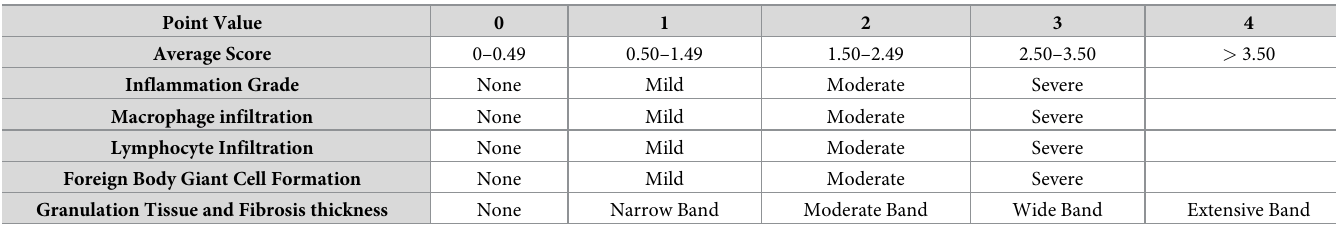
Table 1. Scoring system used to evaluate the histopathology samples